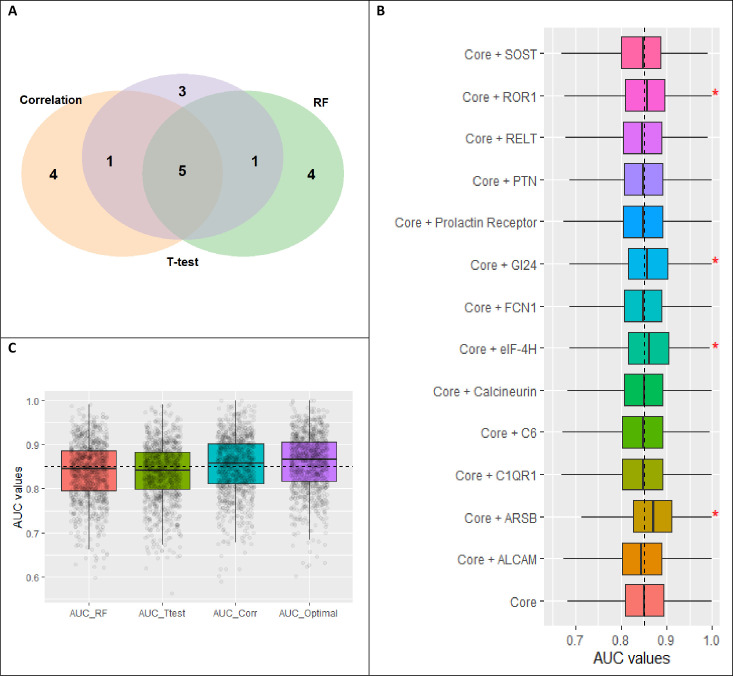
Optimization of the predictive proteins.(A) Identification of the 5 core proteins. The core proteins were among the top-10 proteins identified by each of the 3 methods. (B) Identification of proteins with additive predictive power when combined with the core proteins (red asterisks). (C) Predictive power (AUC) of the top-10 proteins from the three different methods: RF–random forest, Ttest–t-tests, and Corr–correlation compared with the optimal panel of 9 proteins (AUC_Optimal) representing the 5 core proteins and the 4 additional proteins identified in Fig 3B).